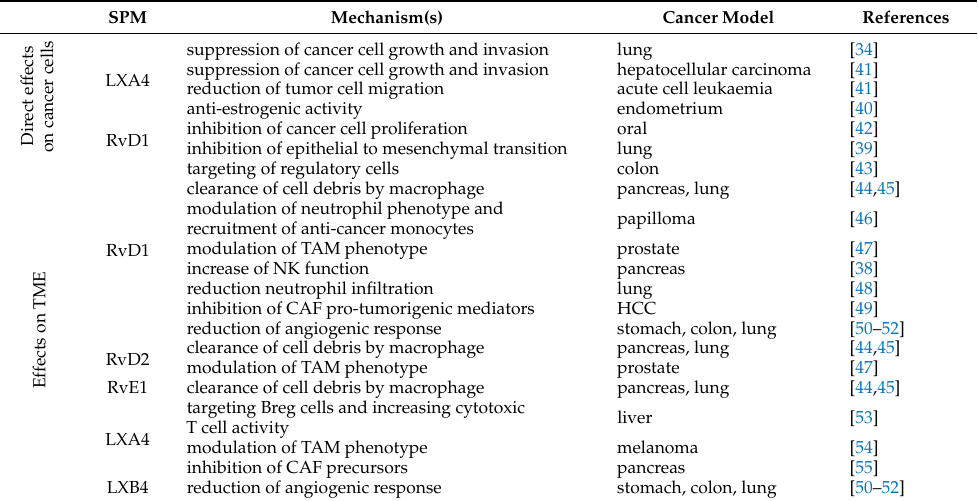
Table 1. Cancer models and the mechanisms by which specific SPMs inhibit cancer progression by directly acting on tumor cells or by targeting different components of the